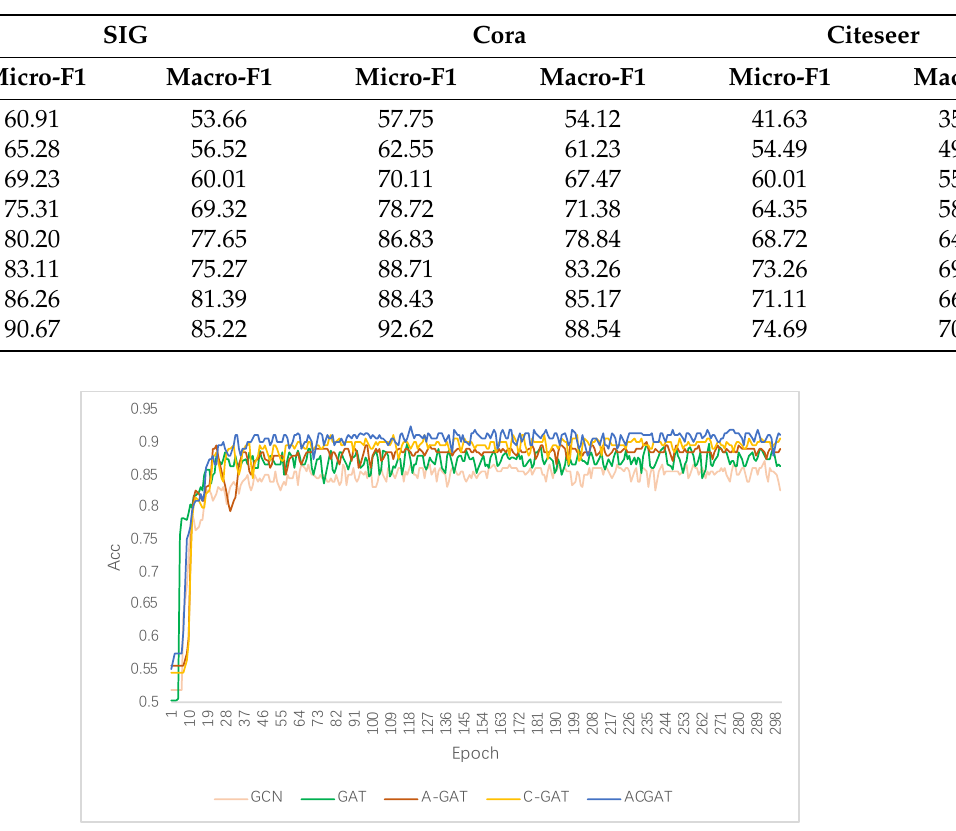
Table 3. Micro-F1 and Macro-F1 of various algorithms.